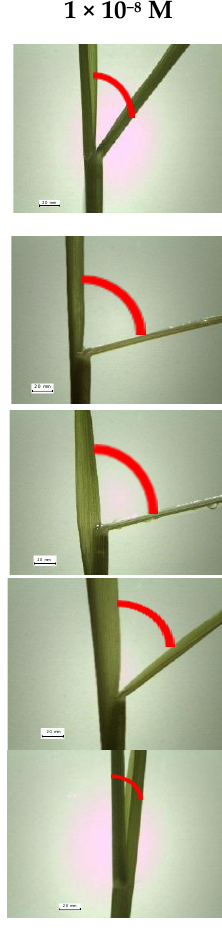
Figure 4. Rice-lamina assays using the second leaf lamina joints of excised leaf segments treated with BR analogs ( 18b , 19b , and 20a ) at 1 × 10 −8 M. Brassinolide ( 1 ) was used as positive control at the same concentrations. The negative control only contained sterile distilled water.